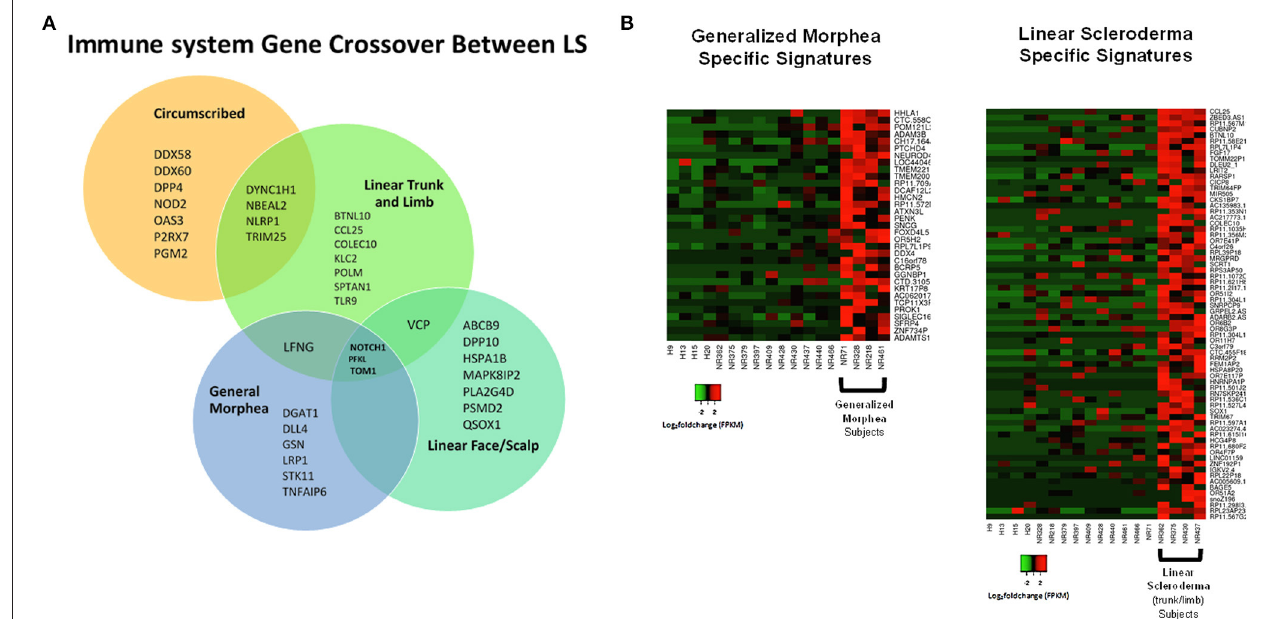
FIGURE 7 | Shared and divergent immunological pathways among localized scleroderma subtypes. (A) Venn diagram demonstrates genetic immunological overlap occurring between subtypes, while having some uniquely different gene expression. (B) The two main LS subtypes, generalized morphea and linear scleroderma, display some areas of unique gene expression profiles that correspond to unique enrichment